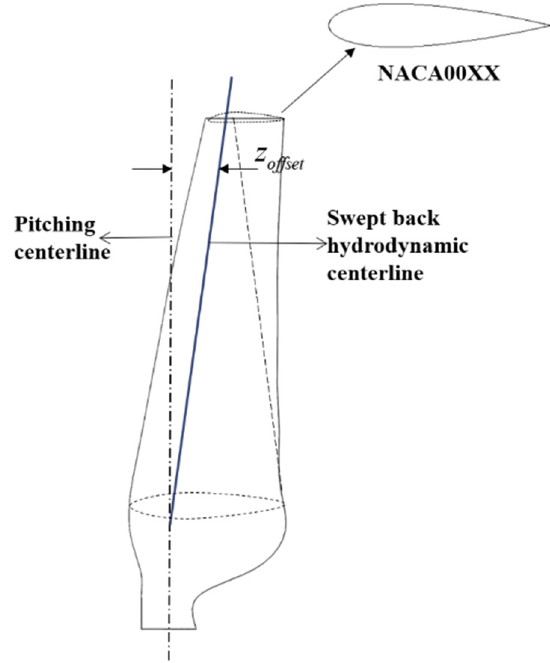
Figure 2. The structure of the backward swept blade. To increase the pitch torque as much as possible, the initial swept offset position of the model in this paper is set at 35% of the blade span, the hydrodynamic center of each section is offset to the trailing edge, and the tip offset reaches the maximum value, which was designed to be 10%R.